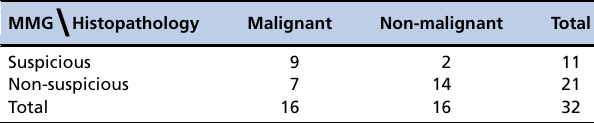
Table 2 - Comparison between mammography (MMG) and histopathology of suspicious breast lumps in at least one of the methods